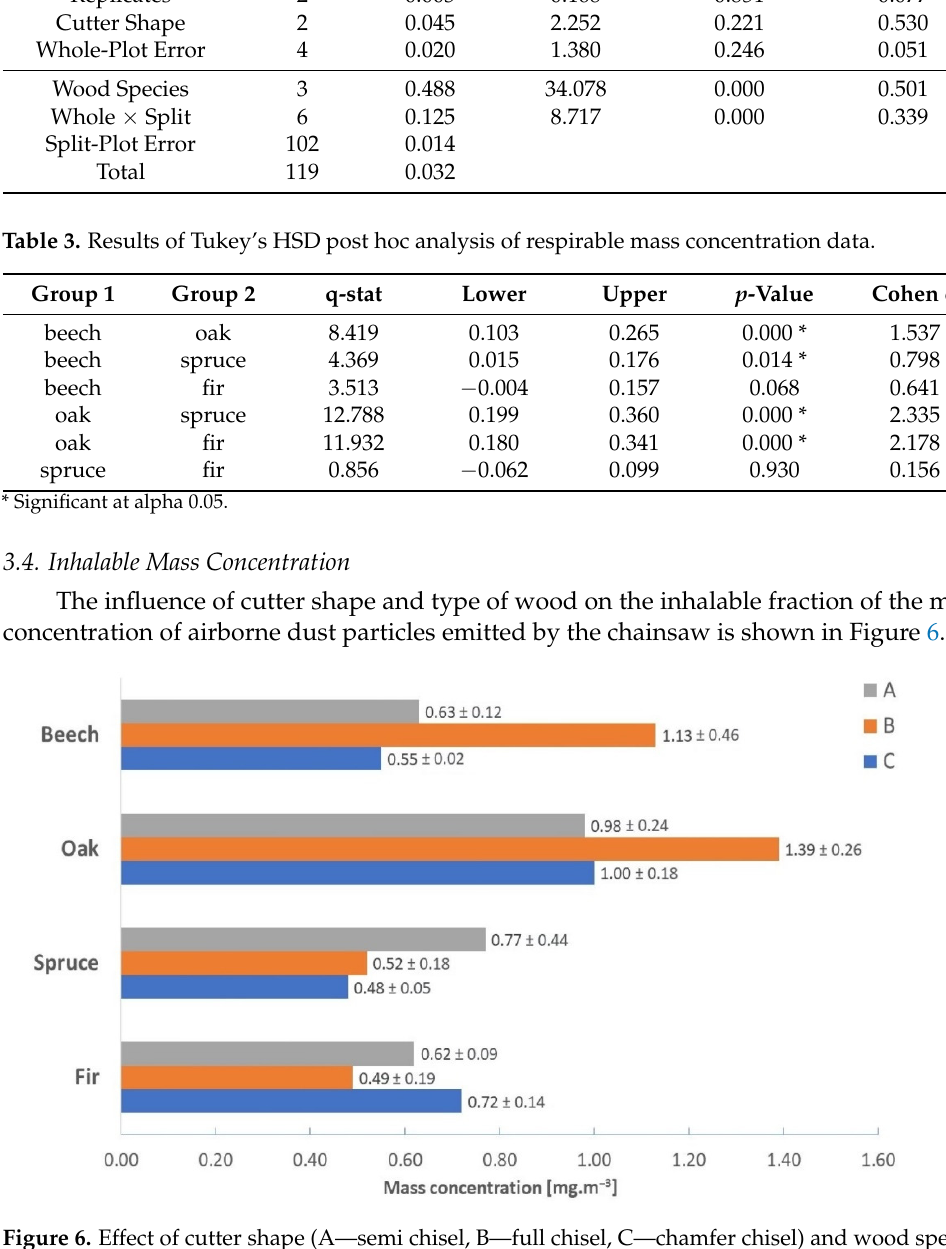
Table 4. Results of split-plot ANOVA for inhalable mass concentration data.